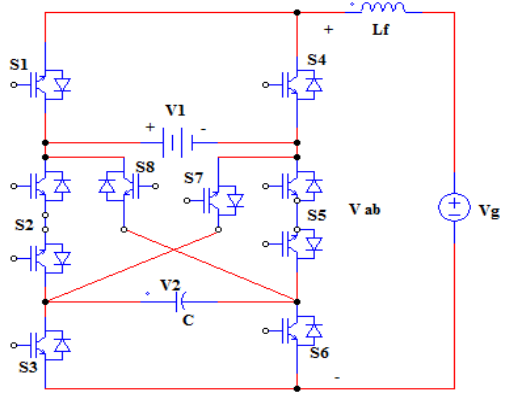
Figure 5. Eight–ten-switch, 9-level topology [54]. Figure 5. eight – ten-switch, 9-level topology [54].